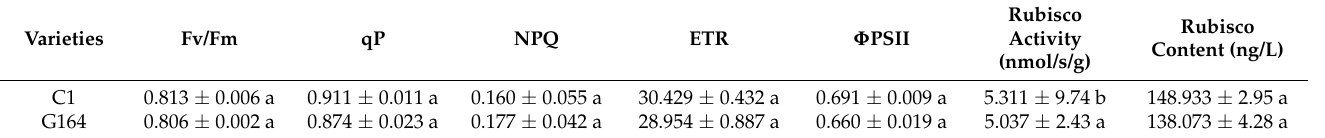
Table 2. Chlorophyll fluorescence parameters and enzyme characteristic of Rubisco in the sword leaves of high- and low-light efficiency germplasm resources C1 and